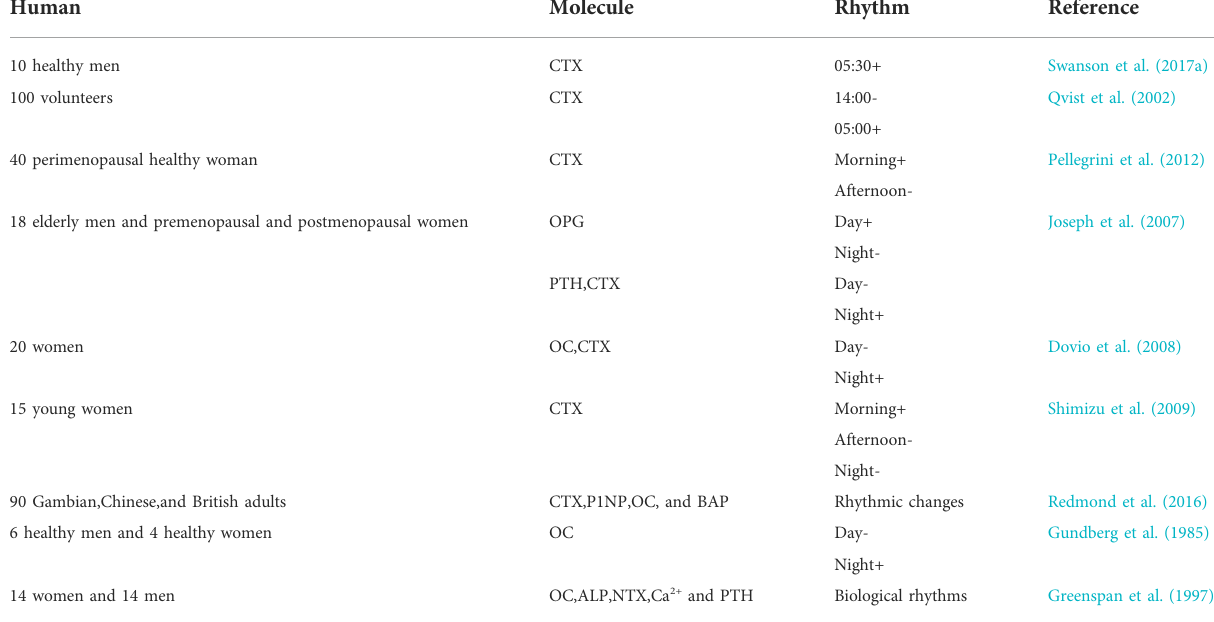
TABLE 3 Human bone remodeling markers are rhythmic in